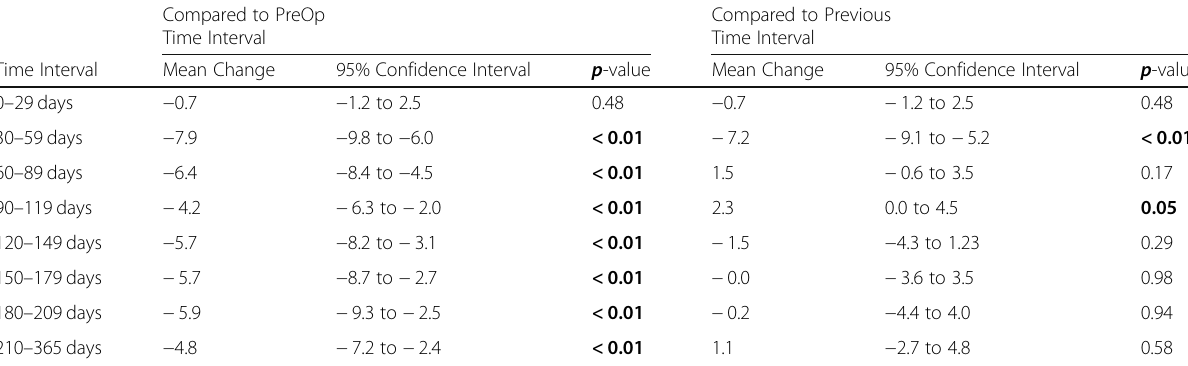
Table 3 Mean change across time for pain interference from linear mixed model analysis ( n = 88) Compared to PreOp Time Interval